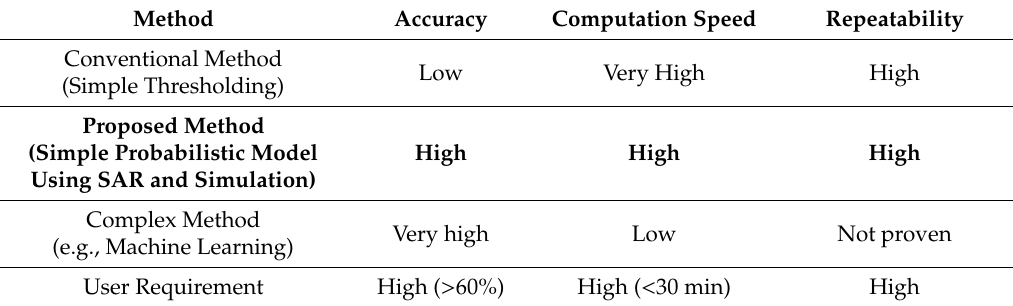
Table 5. Summary of the advantages and disadvantages of the proposed method in terms of flood detection using ALOS-2